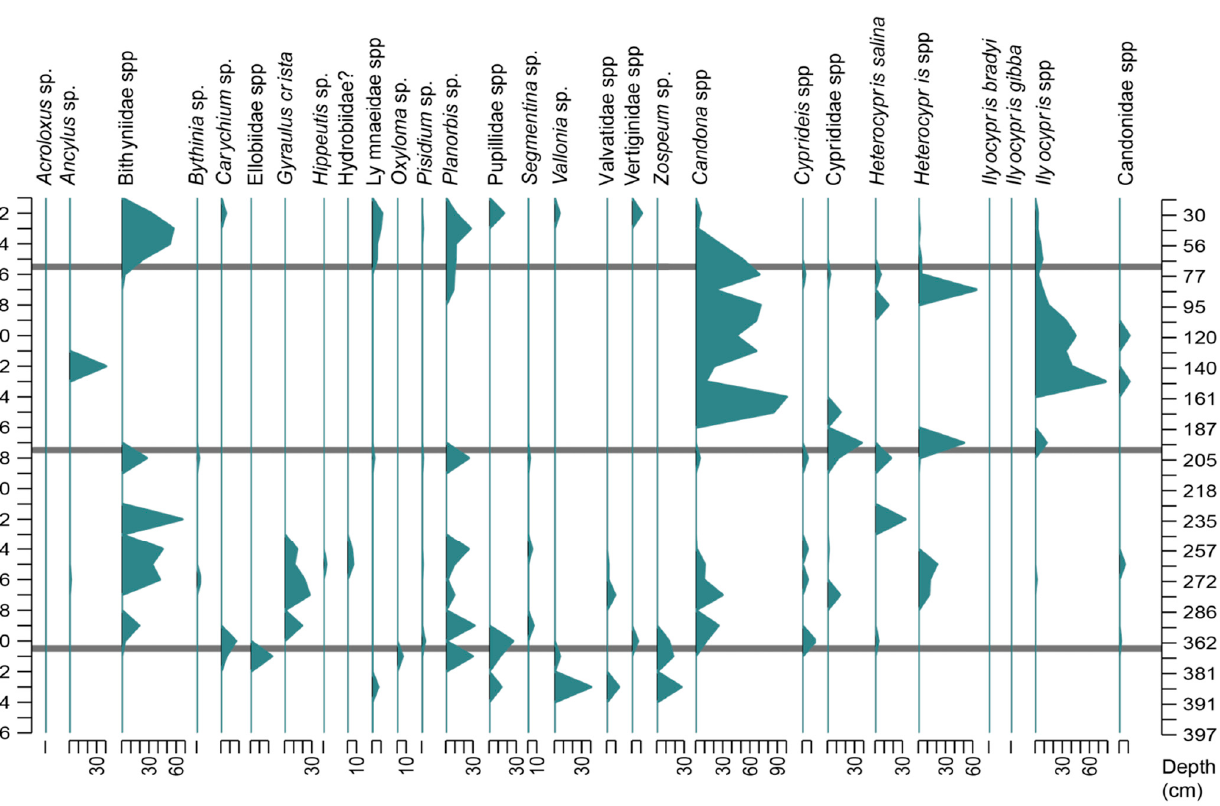
Figure 5. Stratigraphic plot for ALM4, mollusc and ostracod taxa. The horizontal grey lines indicate the limits of molluscan–ostracod units. Table 2. List of molluscs found in sediments of Lerna and their respective habitats and environ ‐ ments.